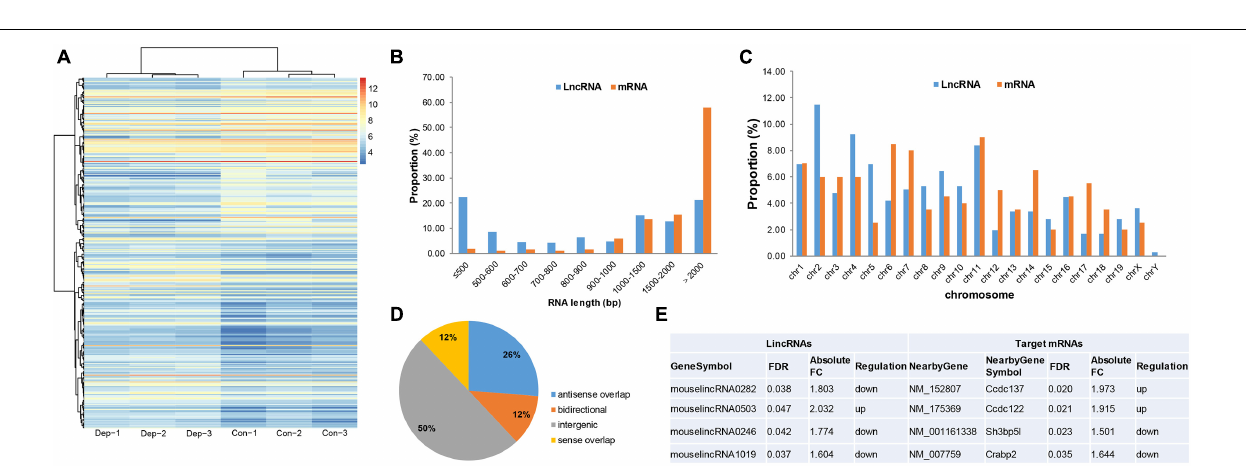
FIGURE 2 | Upstream regulator prediction and protein–protein interaction (PPI) analysis of DEGs in gut microbiota-dysbiosis mice. (A) Histogram showing the inhibited and activated upstream regulators of DEGs. (B) Graphical summary of the upstream regulators. (C) The highest-ranked upstream regulator, IFNG, and its downstream DEGs. (D) PPI network analysis of DEGs.